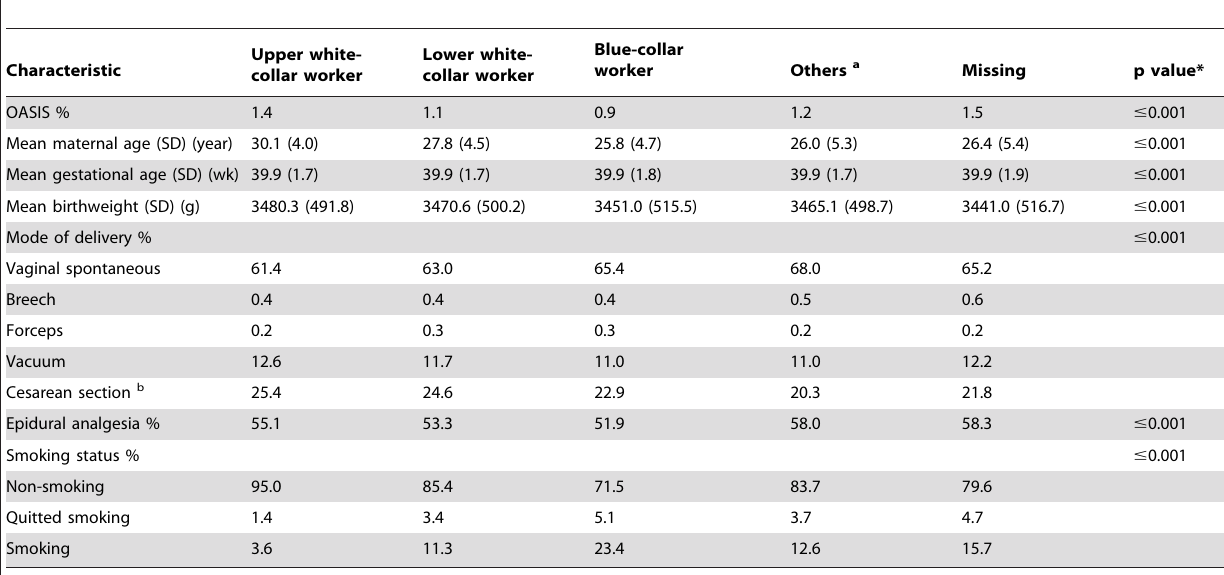
Table 2. Characteristics and background information were compared in nulliparous women including women with first vaginal delivery after a prior cesarean section between SES groups in 1991 2 2010 in